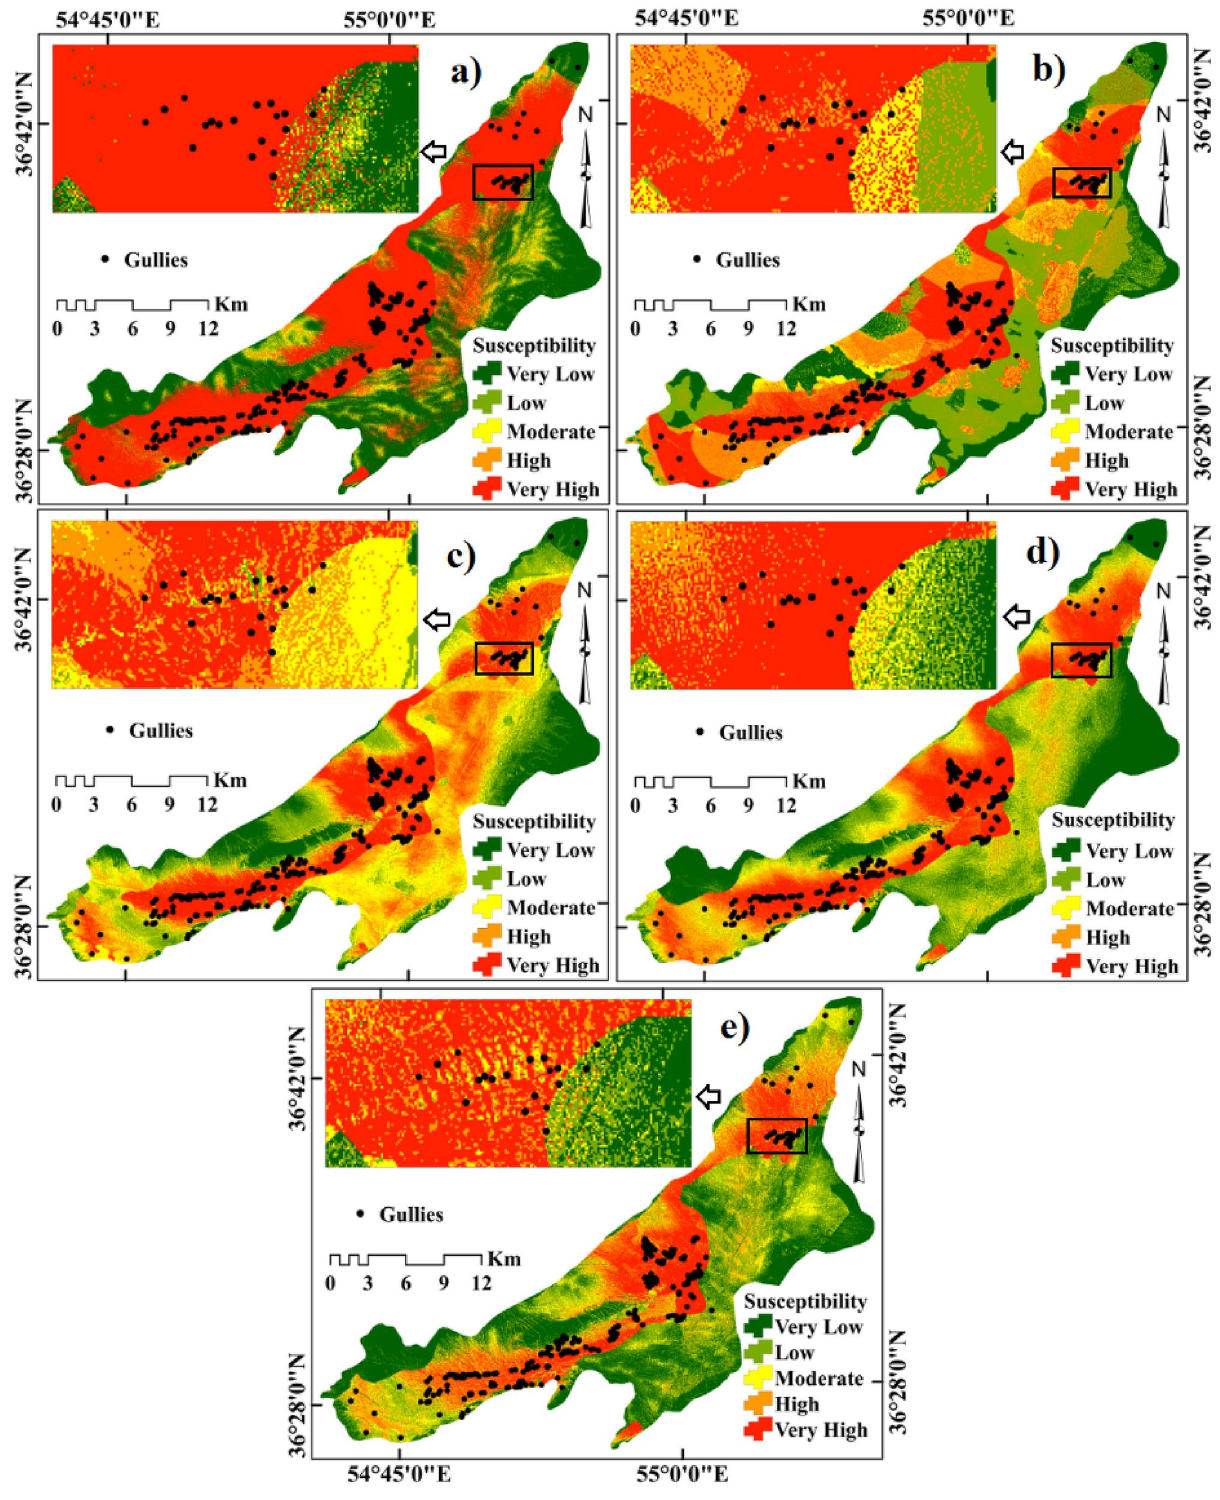
Figure 1. Gully erosion susceptibility mapping using ( a ) credal decision tree (CDT), ( b ) CDT-Dagging, ( c ) CDT-ADTree, ( d ) CDT-Bagging, ( e ) CDT-rotational forest (RF). ArcGIS 10.5 software was used for preparing this map (https ://deskt op.arcgi